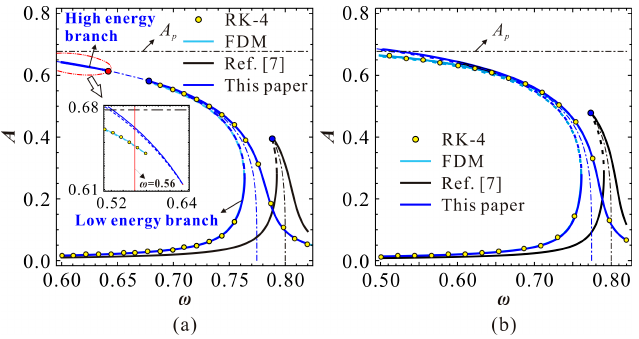
Figure 3. Frequency response curve for α = 0.8, γ = 0.1, µ = 0.005 and δ = 100 ( a ) ρ = 9.86 × 10 − 5 ; ( b ) ρ = 1.20 × 10 − 4 (note that ρ i = 9.89 × 10 − 5 ; solid line: stable solutions; dashed line: unstable solutions).